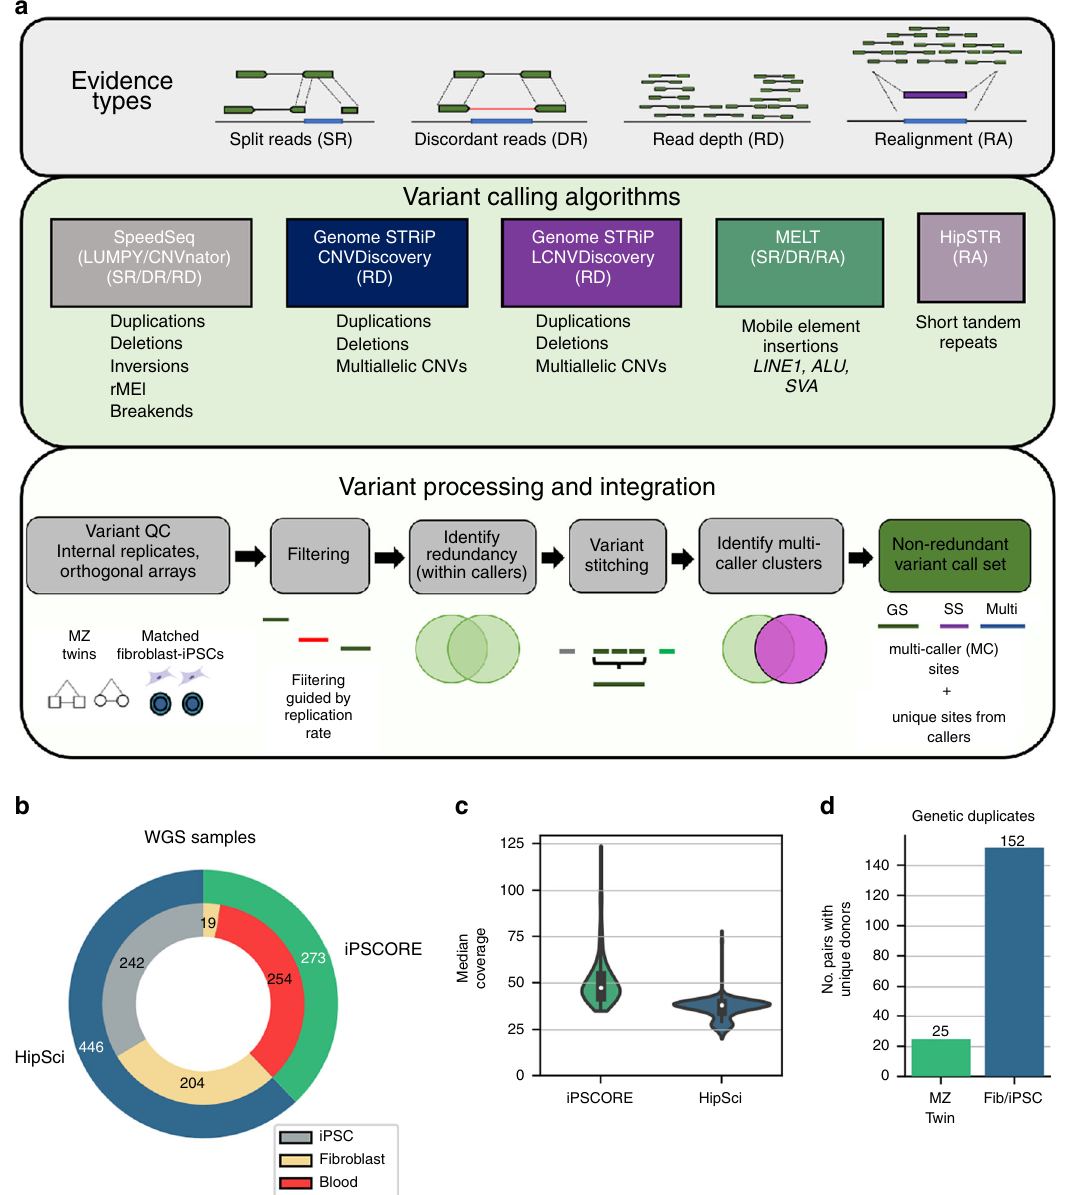
Fig. 1 Variant calling, processing, and i2QTL WGS samples. a Illustration of the evidence types from short read sequencing data utilized in variant calling (top). Description of the variant callers utilized, the types of variants they identify, and the evidence they use (middle). Flowchart showing the processing, quality control (see Methods), and integration of SVs from different variant callers (bottom). b Pie chart showing the number of whole-genome